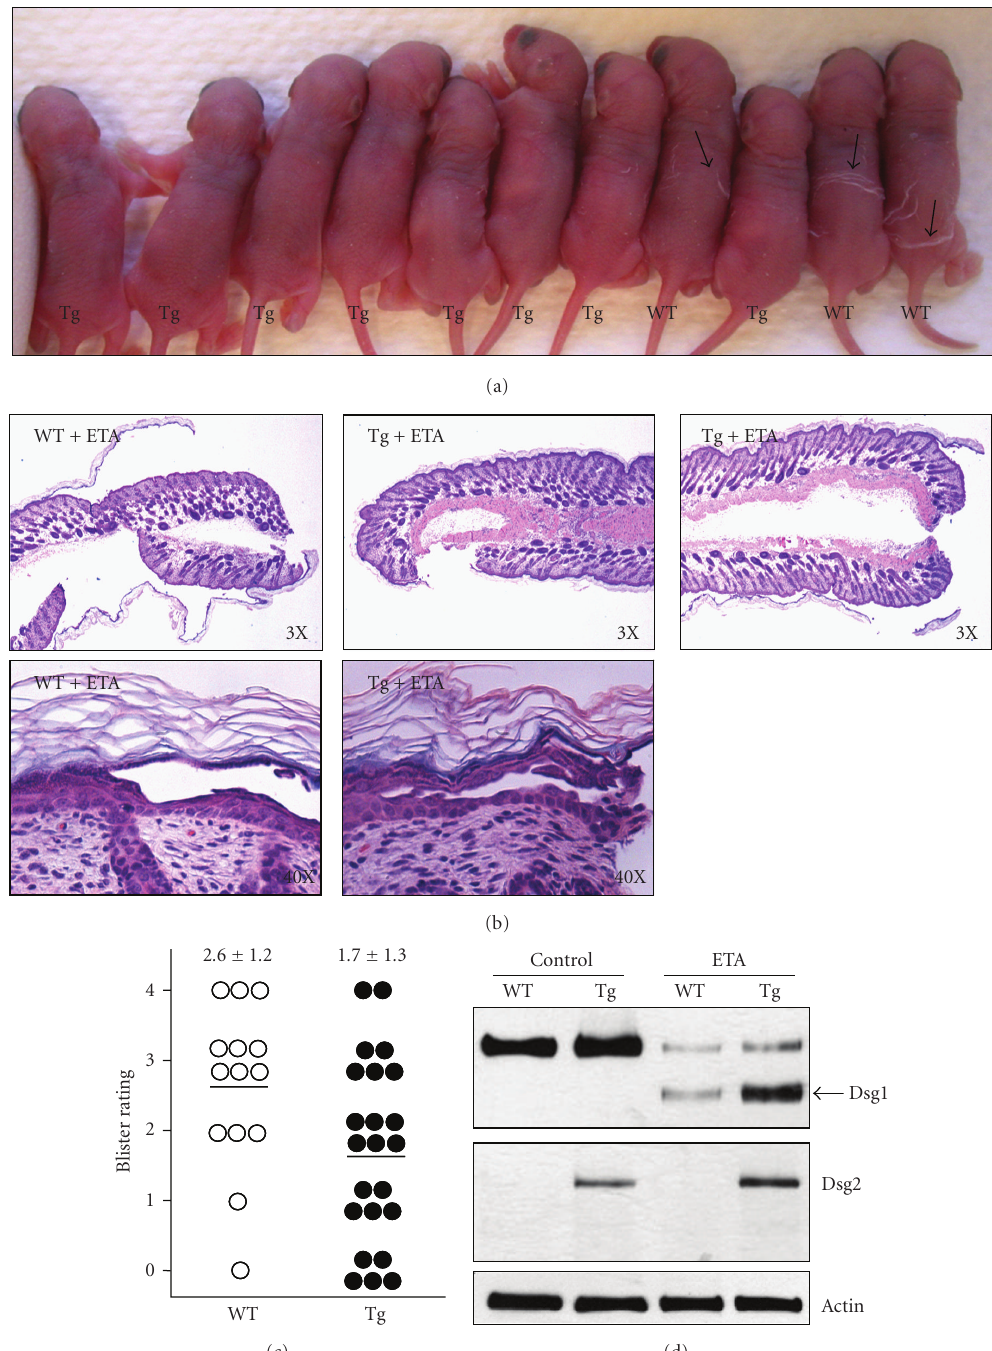
Figure 2: Superficial expression of Dsg2 o ff ers protection from ETA-induced blister formation. (a) Newborn WT and Inv-Dsg2 Tg mice were injected subcutaneously with 0.5 μ g ETA in PBS. Visible blisters were observed in WT but not Tg mice, 6–8 hours after ETA treatment. (b) Mice were sacrificed, and their skin was processed for histological analysis, revealing slightly more extensive blisters in the WT mice ( n = 14), as compared to Tg mice ( n = 23), in response to ETA. Top panels show 3X magnification, and lower panels show 40X magnification of the site of blister formation. (c) The extent of blistering was graded based on the following semiquantitative scale: 0: no blisters, 1+: minor blisters at the edge; 2+: localized blisters < 50%; 3+: extensive blisters > 50%; and 4+: very extensive blisters > 75%. Each dot represents one mouse. The average blister scores were 2.6 ± 1.2 for WT and 1.7 ± 1.3 for Tg. These values were statistically significant, P ≤ .038260921 (2-tailed unequal variance) or ≤ .01913046 (1-tailed unequal variance). (d) The back skin biopsies were homogenized in Laemmli bu ff er, proteins were resolved with SDS-PAGE and immunoblotted for Dsg1 (27B2), Dsg2-Flag (Flag), and Actin (for equal loading). Western blotting demonstrates that ETA cleaved Dsg1 (arrowhead), but not Dsg2. Note . antibody 27B2 was raised against the cytoplasmic epitope of human Dsg1, and recognizes mouse Dsg1- a , - β , and - γ . Thus, the full-length signal is most likely ETA-resistant Dsg1- γ